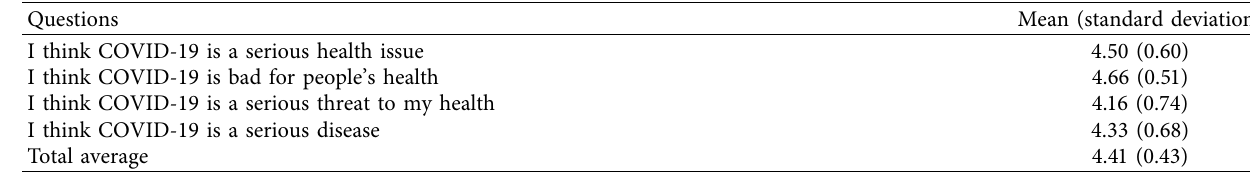
Table 2: COVID-19 risk perception of the respondents.